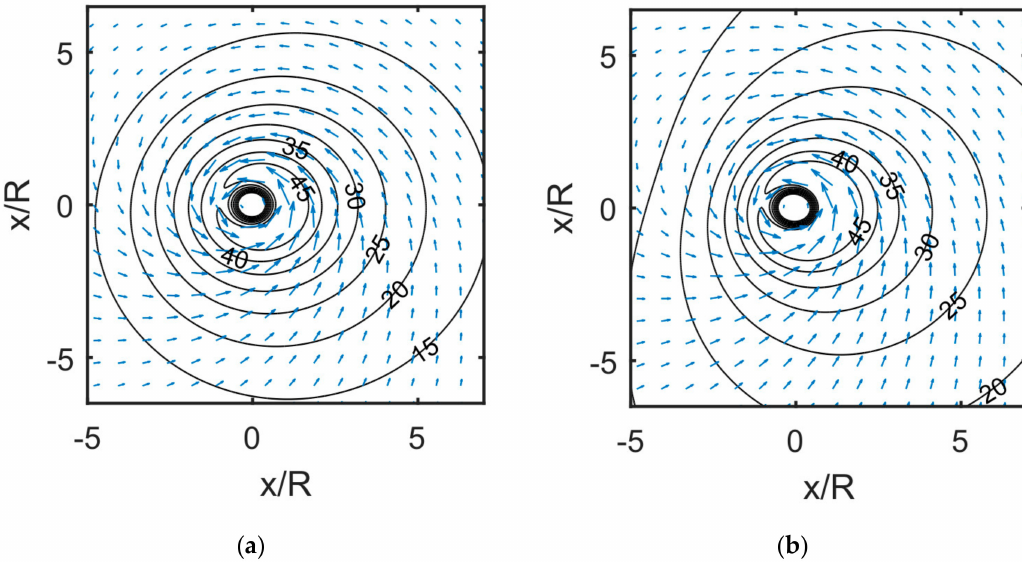
Figure 1. Tropical cyclone wind fields. ( a ) Left panel—calculated with a single Holland vortex (1) and parameters, p 0 = 950 HPa, p n = 1005 HPa, R = 30 km, B = 1.75 and V fm = 5 ms − 1 ( b ) Right panel—calculated with a double Holland vortex and parameters, p 0 R 1 = 30 km, R 2 = 300 km, B 1 = 1.75 and B 2 =